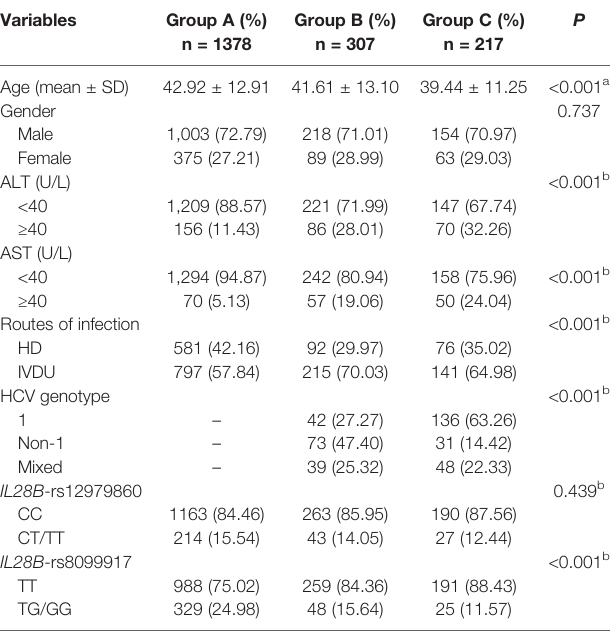
TABLE 1 | Demographic and clinical characteristics among HCV control, spontaneous clearance, and persistent infection groups.